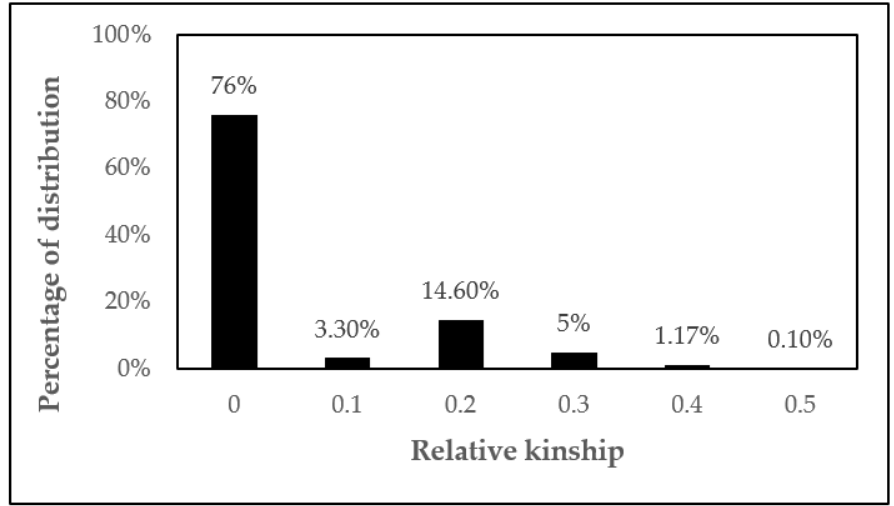
Figure 1. The distributions of pair-wise kinship coefficients for 45 genotypes of C. canephora